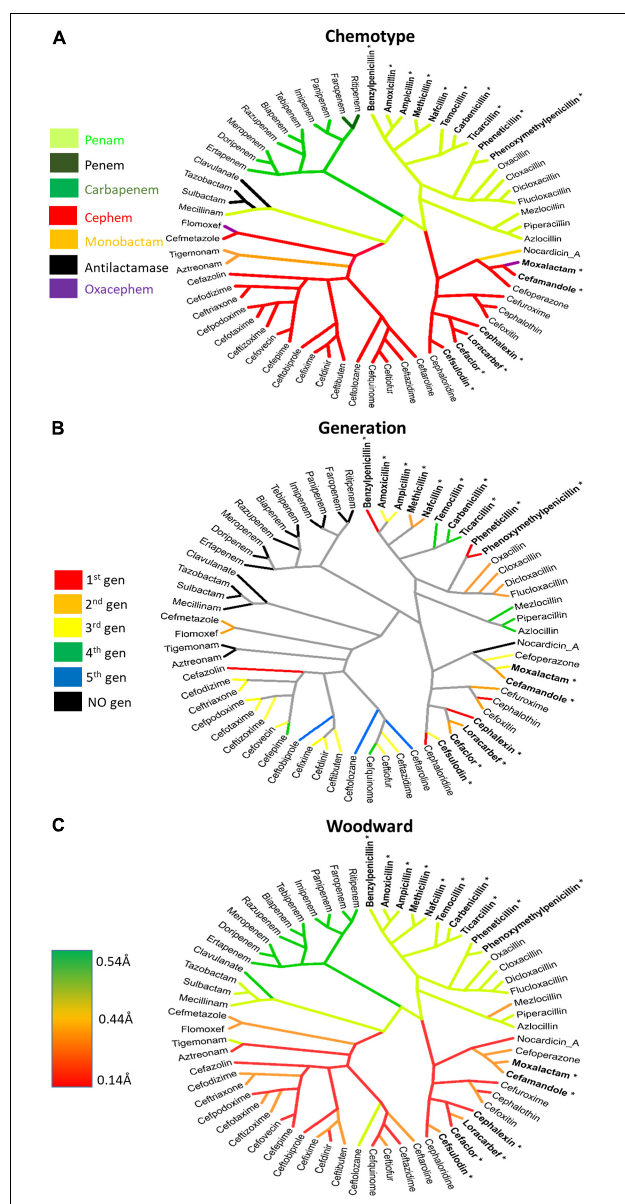
FIGURE 5 | Lactamomes depicting (A) chemotype, (B) compound generation, and (C) h -Woodward values. (A) The chemotype is a reproduction of Figure 4 to aid comparisons to the other figures. (B) The generational lactamome assigns generation levels (1st–5th) to individual drugs based on how they most currently referenced in literature. Individual drugs that do not conform to generational naming are colored in black. (C) h -Woodward lactamome is colored using a heatmap with higher h -Woodward values in green and lower h -Woodward values in red. Bolded lactams marked with an asterisk indicate drugs with high allergy ( > 10%) relating to the R 1 benzyl